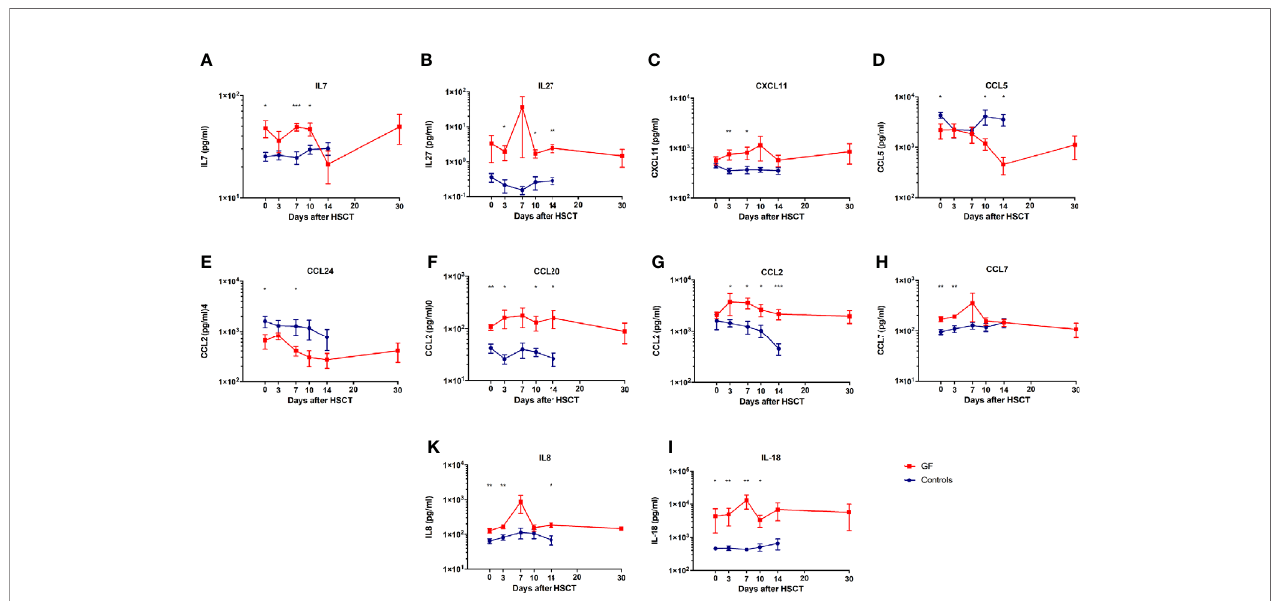
FIGURE 1 | Cytokines and chemokines modulated during GF. Serum levels of IL7 (A) , IL27 (B) , CXCL11 (C) , CCL5 (D) , CCL24 (E) , CCL20 (F) , CCL2 (G) , CCL7 (H) , IL8 (K) , and IL18 (I) in patients who either did (red line) or did not (blue line) experience GF are shown. In all graphs mean and SEM for each variable are represented. * p<0.05, ** p<0.01, ***